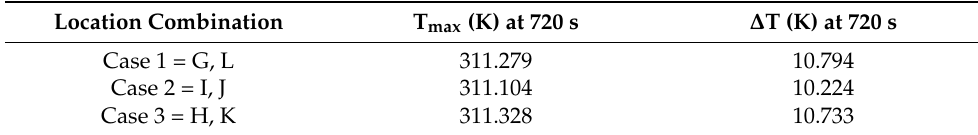
Figure 15. Inlets (G–I) and outlets (J–L) locations (dimensions in mm)–HCD. Table 6. Thermal performance of location combinations at t = 720